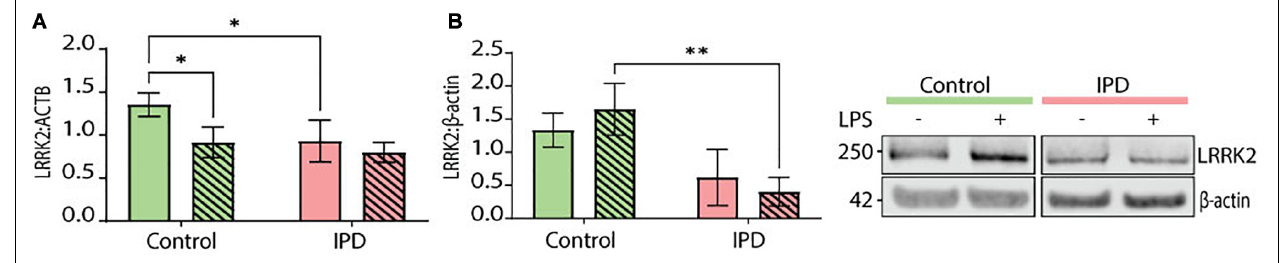
FIGURE 5 | LRRK2 levels in iPSC-derived microglia. (A) IPD microglia have a significant decrease of LRRK2 expression at basal level (normalized to ACTB ). (B) IPD microglia show a significant downregulation of total LRRK2 protein levels (normalized to β -actin) compared to control cells upon LPS treatment only. ∗ p < 0.05; ∗∗ p < 0.01; IPD, idiopathic PD; LRRK2, Leucine-rich repeat kinase 2.